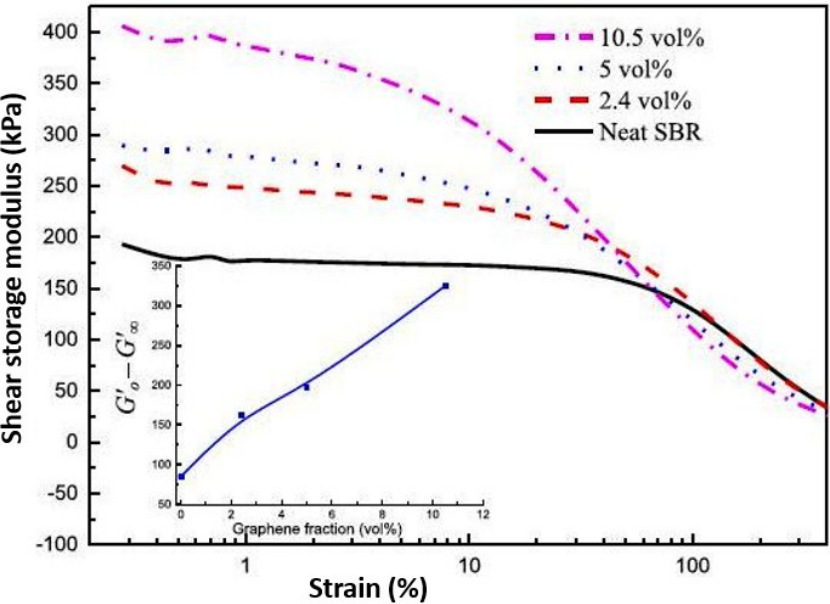
Figure 23. Payne effect of elastomer and its nanocomposites. Reproduced with permission from [174], Copyright Elsevier, 2014.